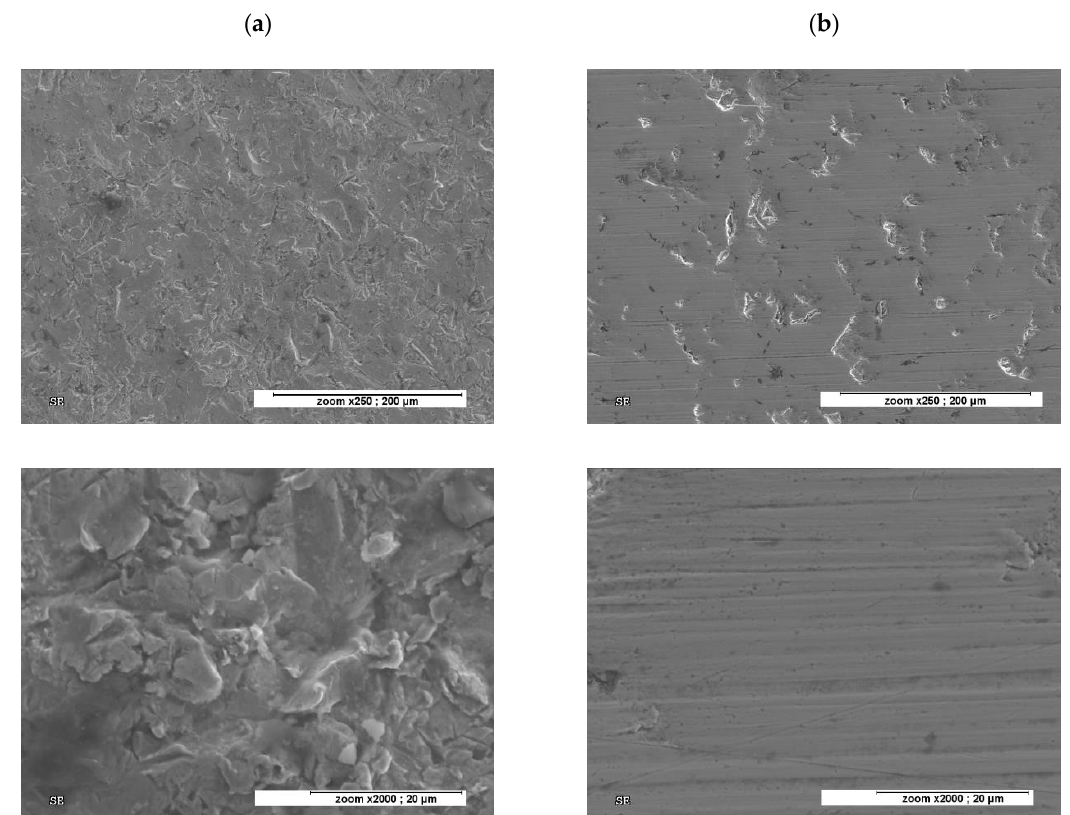
Figure 20. Surface images under SEM: ( a ) before machining; ( b ) after machining in μ m.